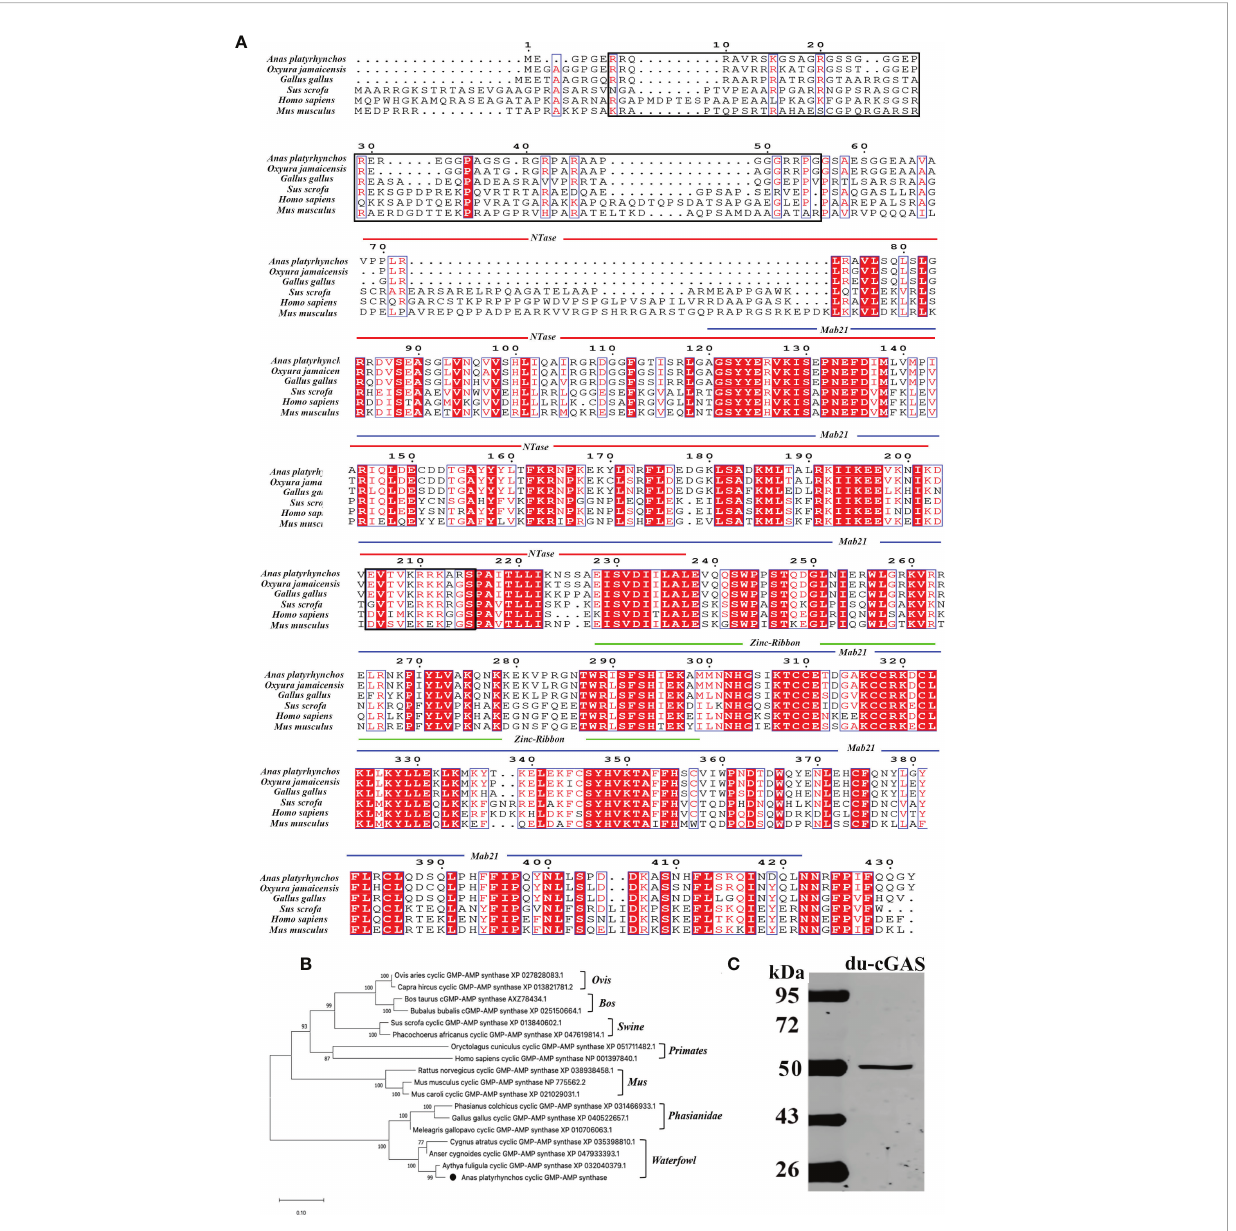
FIGURE 1 Amino acid sequence analysis, functional domains prediction, and preparation of du-cGAS positive serum. (A) Multiple sequence alignments of cGAS sequences. Predicted domains are highlighted in different colors: NTase core (blue), Mab21 (red) and Zinc-Ribbon (green). Conserved residues are shaded in red. Conserved NLS sequence was highlighted by black frame. (B) A phylogenetic tree of the cGAS sequences. Black circle ( (cid:129) ): the cloned duck cGAS. (C) Western blotting analysis of the mouse anti-Mab21 positive serum binding the endogenous du-cGAS